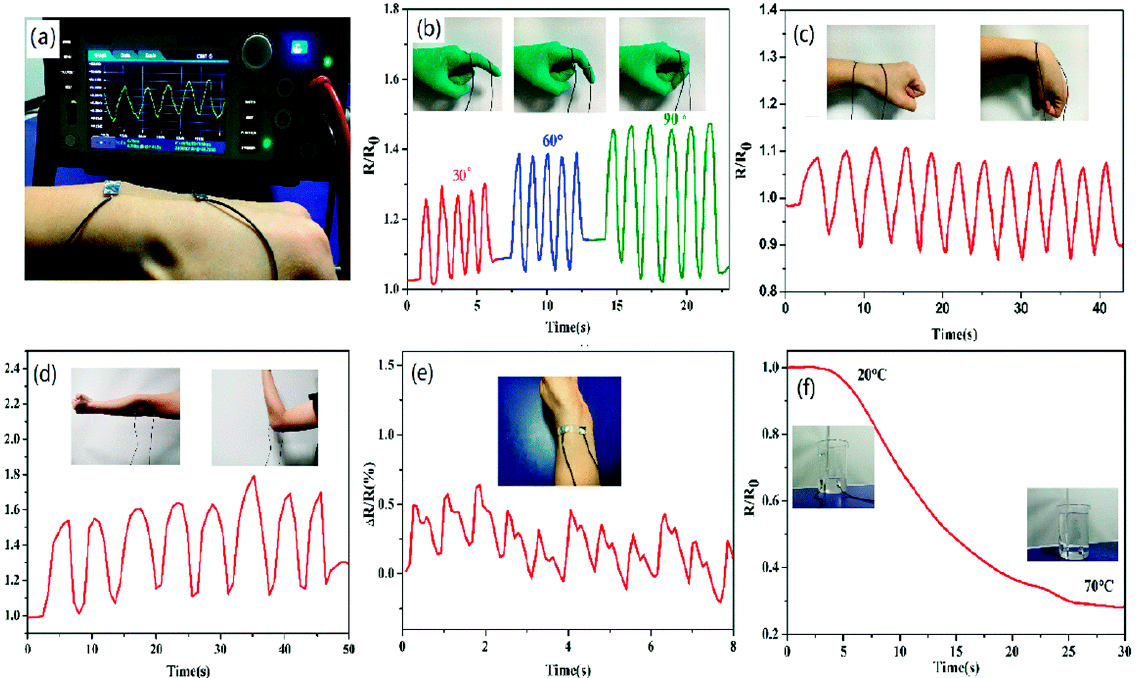
Figure 19. ( a ) Image of the testing of the ionogel strain sensor. ( b – d ) Relative resistance change of the ionogel for detecting different human motion: bending and straightening of the index finger, the wrist, and the elbow. ( e ) Relative resistance change of the ionogel for monitoring the beating of the human pulse. ( f ) Relative resistance change of the ionogel for monitoring the temperature change. Reprinted with permission from [204].